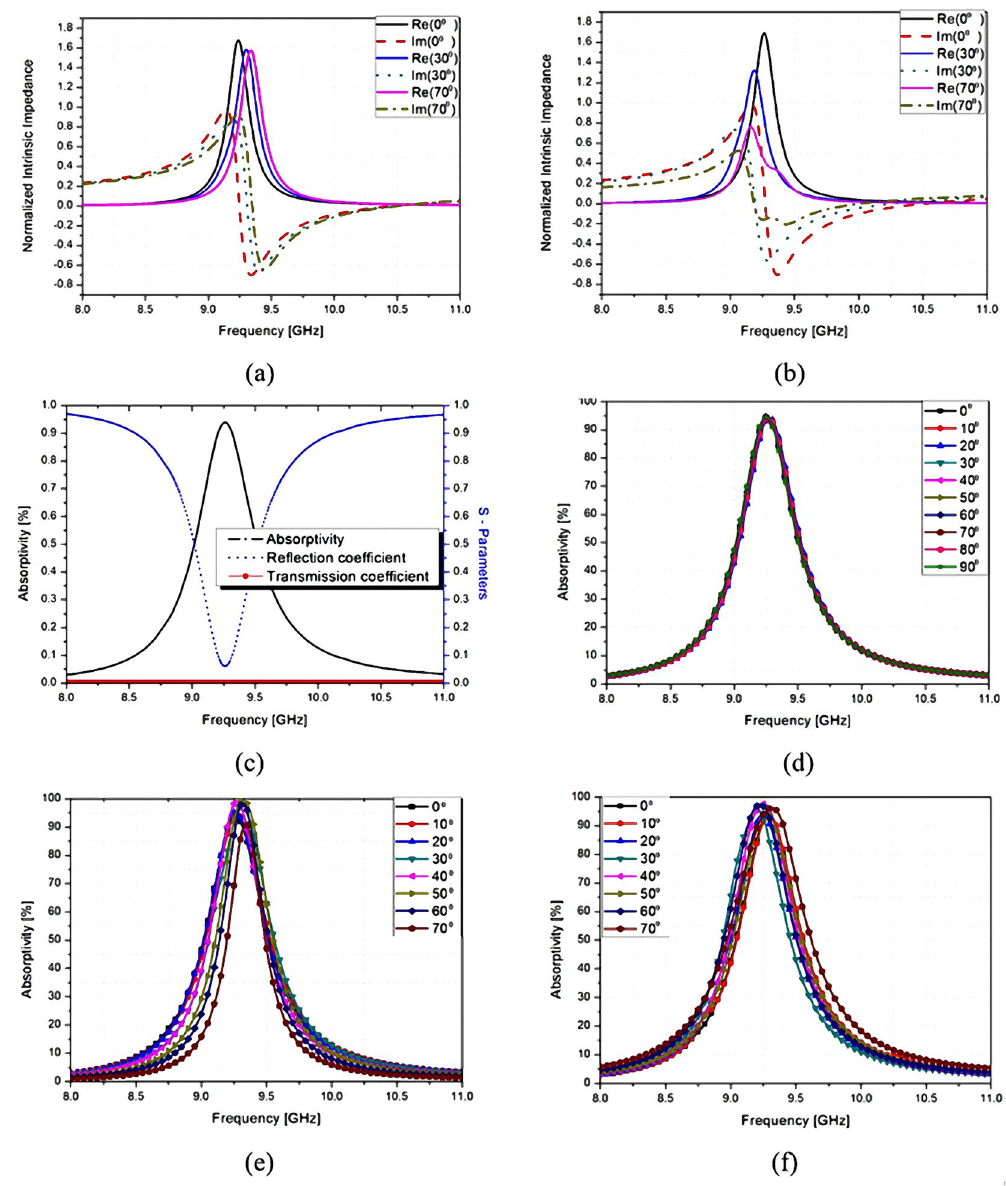
Figure 4. Simulated normalized impedances of the proposed MM absorber for different incident angles for ( a ) TE mode and ( b ) TM mode. ( c ) Simulated reflection coefficient, transmission coefficient, and absorptivity of the proposed MM absorber under normal incidence. ( d ) Simulated absorptivity of the proposed absorber for polarization angles φ ranging from 0° to 90° ( d ). Simulated absorptivity of the proposed MM absorber for incident angles θ ranging from 0° to 70° for ( e ) TE mode and ( f ) TM